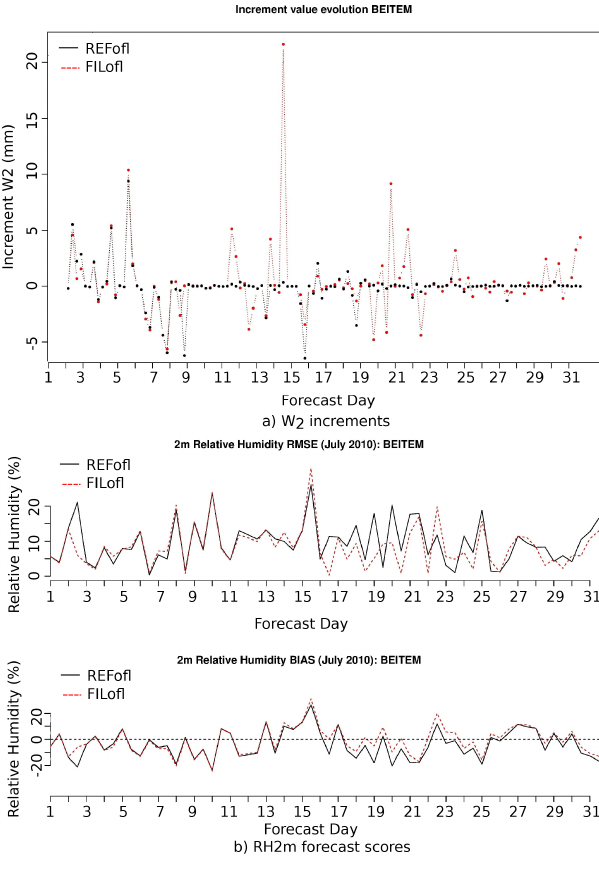
Figure 14. Evolution of the W 2 increments and RH 2m forecast scores at a forecast range of 6h (RMSE and BIAS) during July 2010 in Beitem (Belgium) for REFofl (black) and FILofl (red).